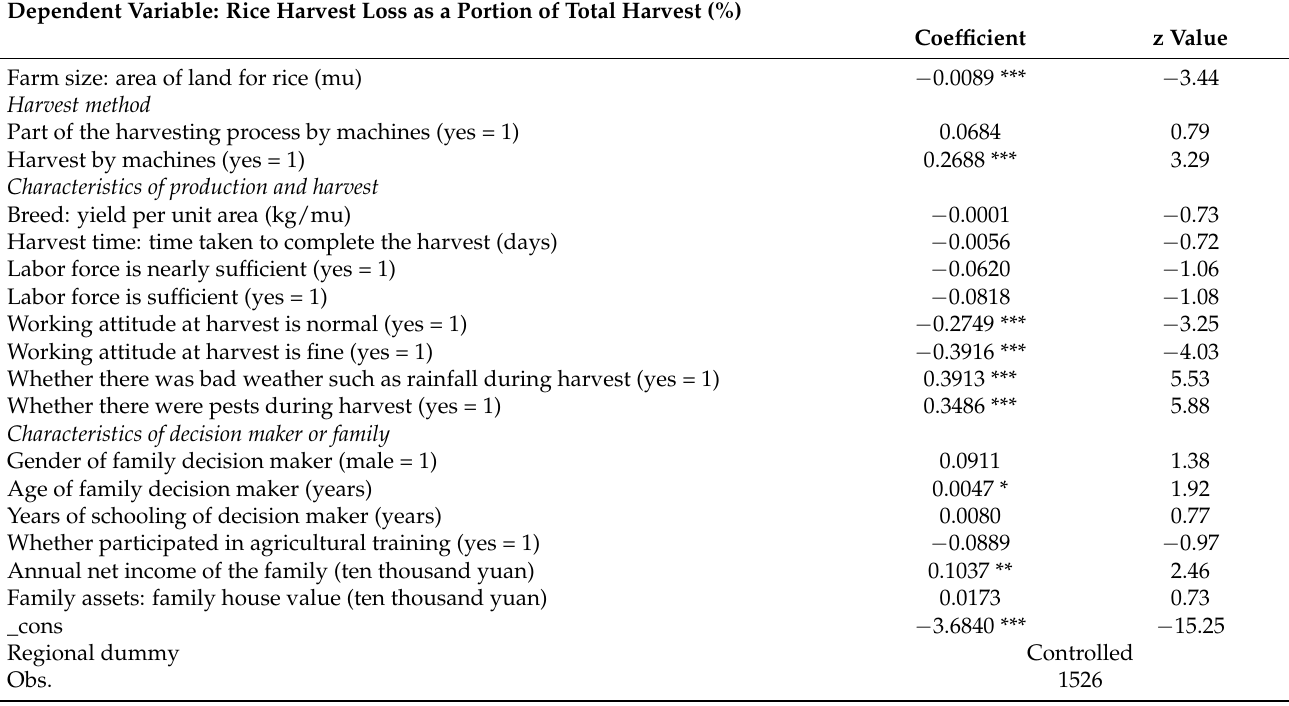
Table 5. Estimation results of the impact of farm size on rice harvest